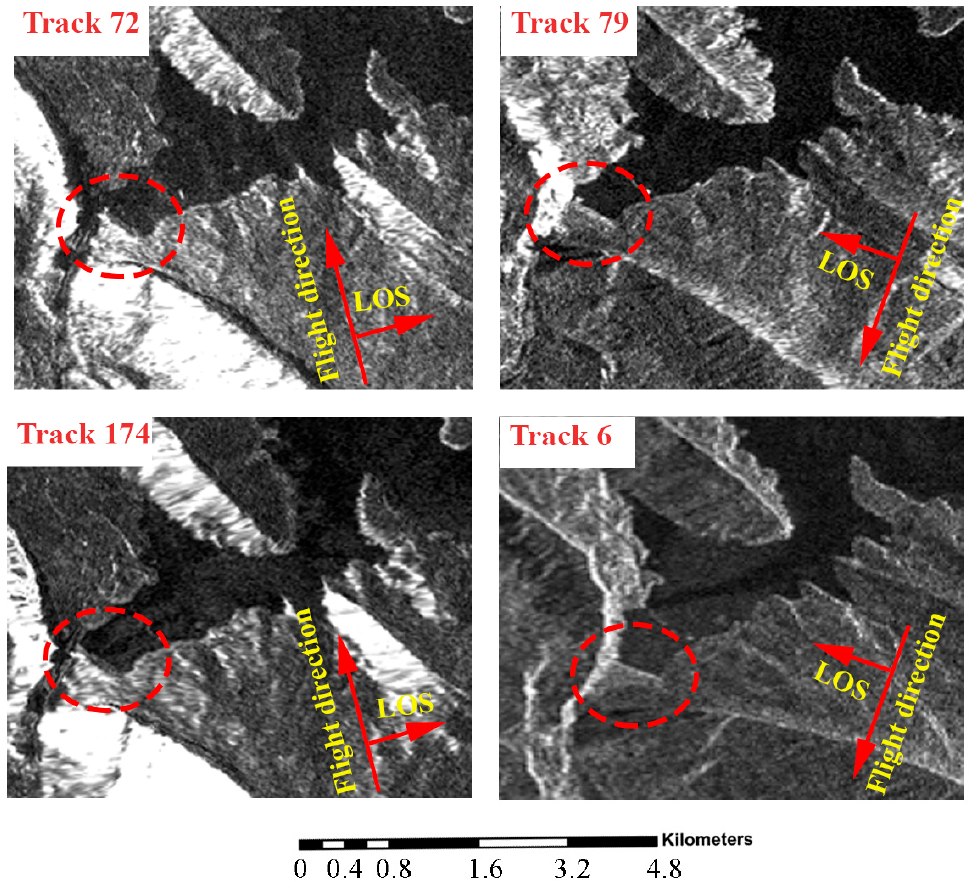
Figure 3. The foreshortening effects on the slope surface; four images from four tracks of Sentinel-1 images over the Darbandikhan dam. The dam is indicated with red circles.